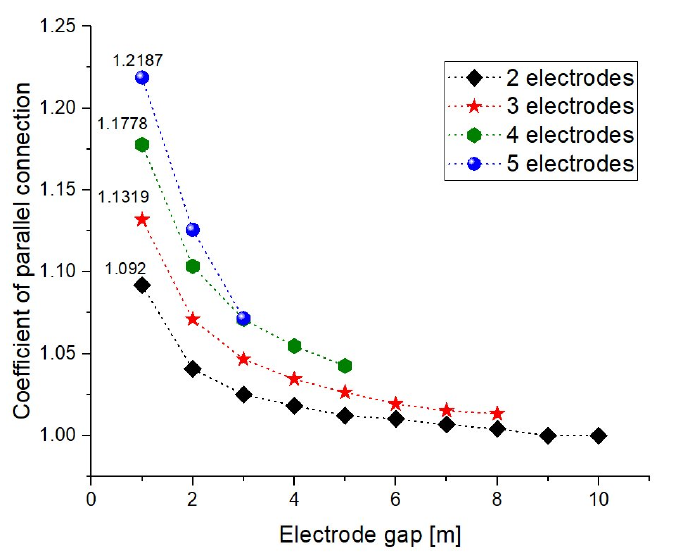
Figure 8. Variation of the coefficient of parallel connection by the electrode gap and the number of